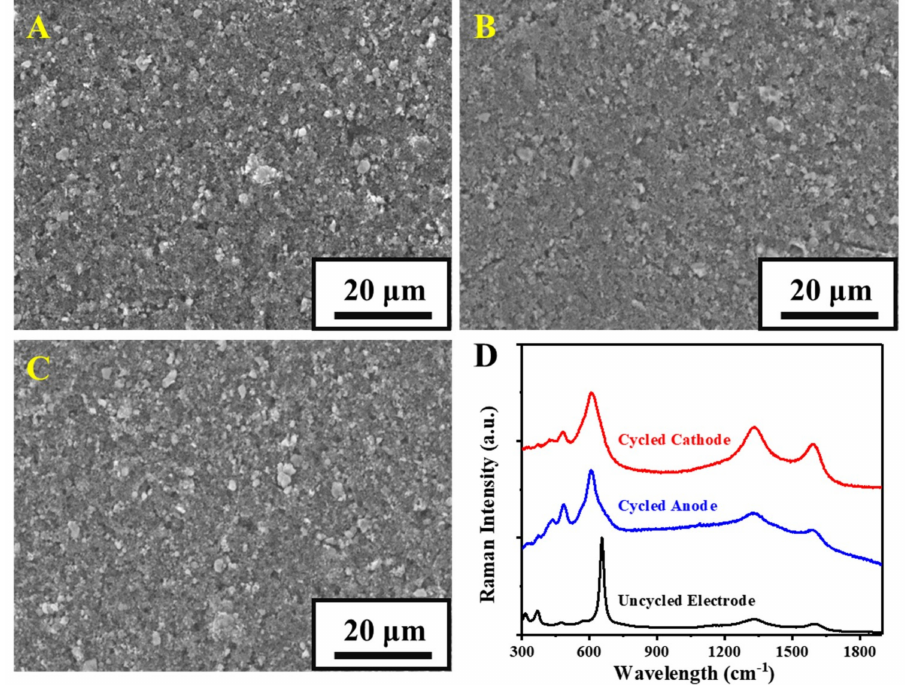
Figure 6. SEM images of ( A ) un-cycled electrode, ( B ) anode cycled for 200 cycles, ( C ) cathode cycled for 200 cycles, and ( D ) Raman spectra of each